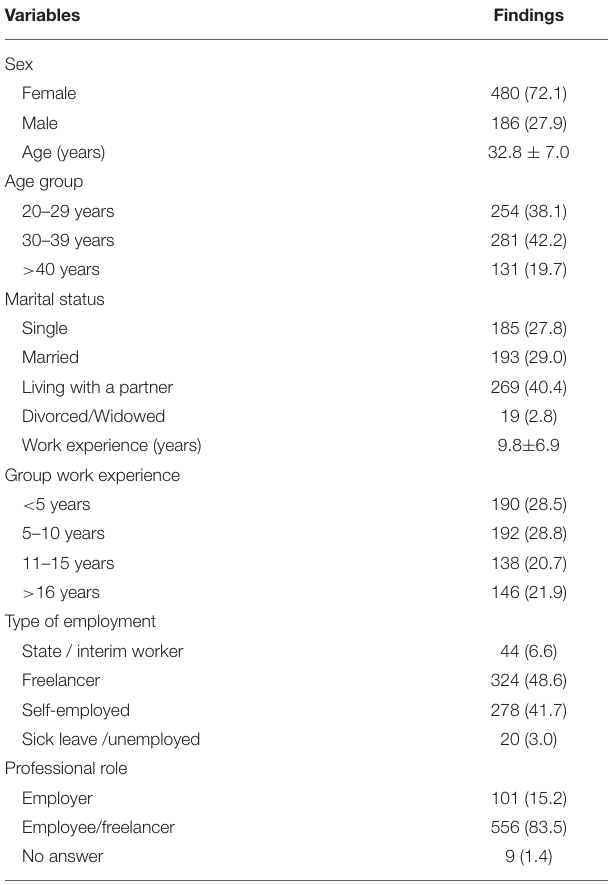
TABLE 1 | Demographic and professional data of the physical therapists ( n = 666).